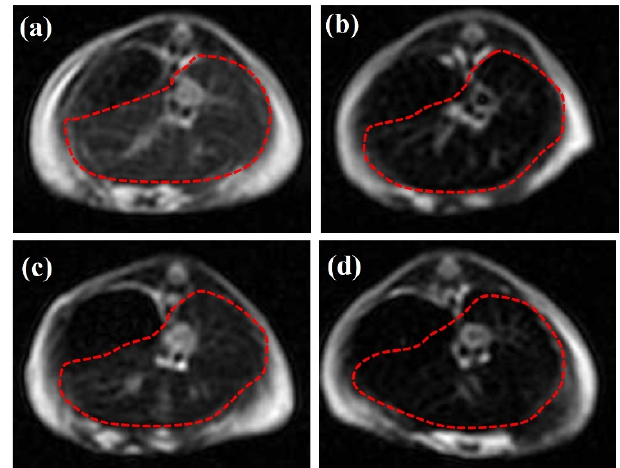
Figure 4. Representative T 2 -weighted ( a – d ) axial MRI data of the liver of n = 4 normal Swiss mice: ( a ) without any CA/DMCA; ( b ) with non-radiolabeled DPD-Fe 3 O 4 CA at a concentration of C CA = 0.1 mg/mL; ( c ) with [ 99m Tc]Tc-DPD-Fe 3 O 4 DMCA at C DMCA = 0.01 mg/mL; ( d ) with [ 99m Tc]Tc-DPD-Fe 3 O 4 DMCA at C DMCA = 0.1 mg/mL. The dotted red lines indicate the area of interest (liver and spleen).